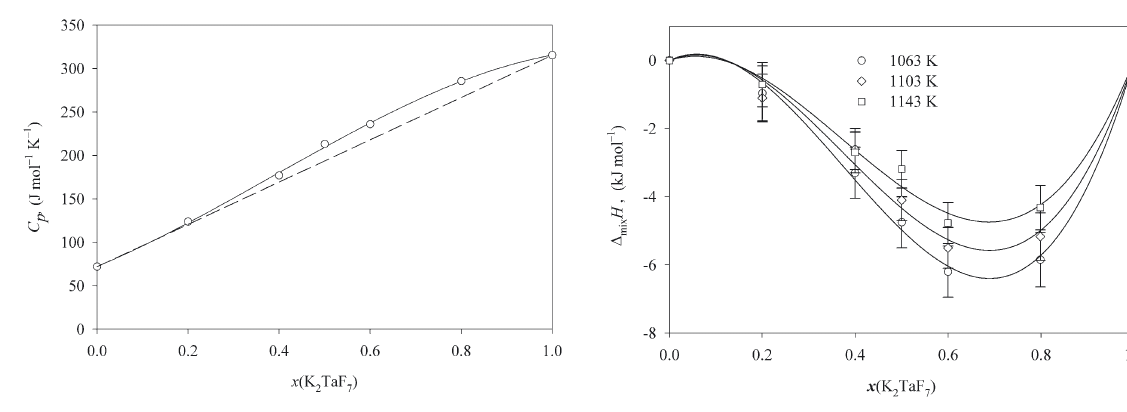
Figure 3. Molar heat capacity of the melt in the system KF–K The dashed line represents additivity.